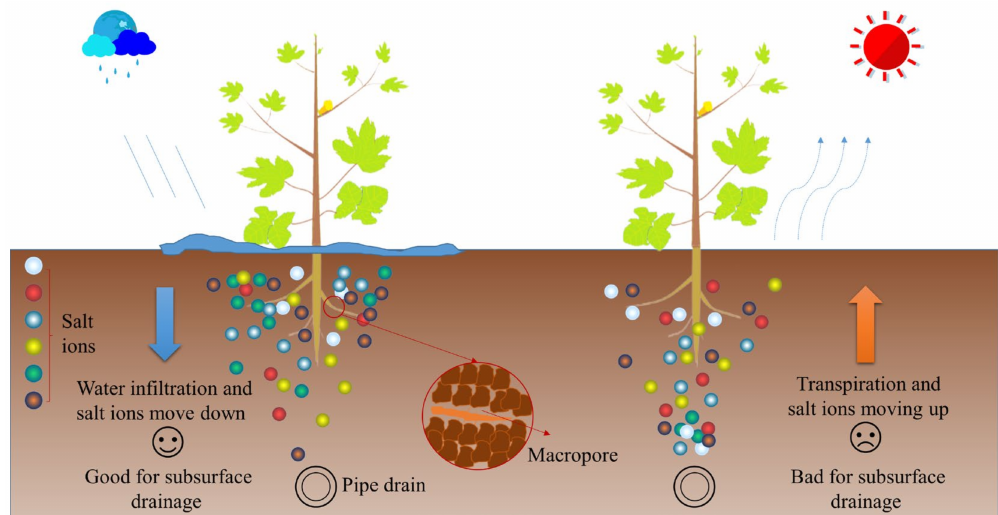
Figure 1. The dual effect of okra roots on the salt movement in saline